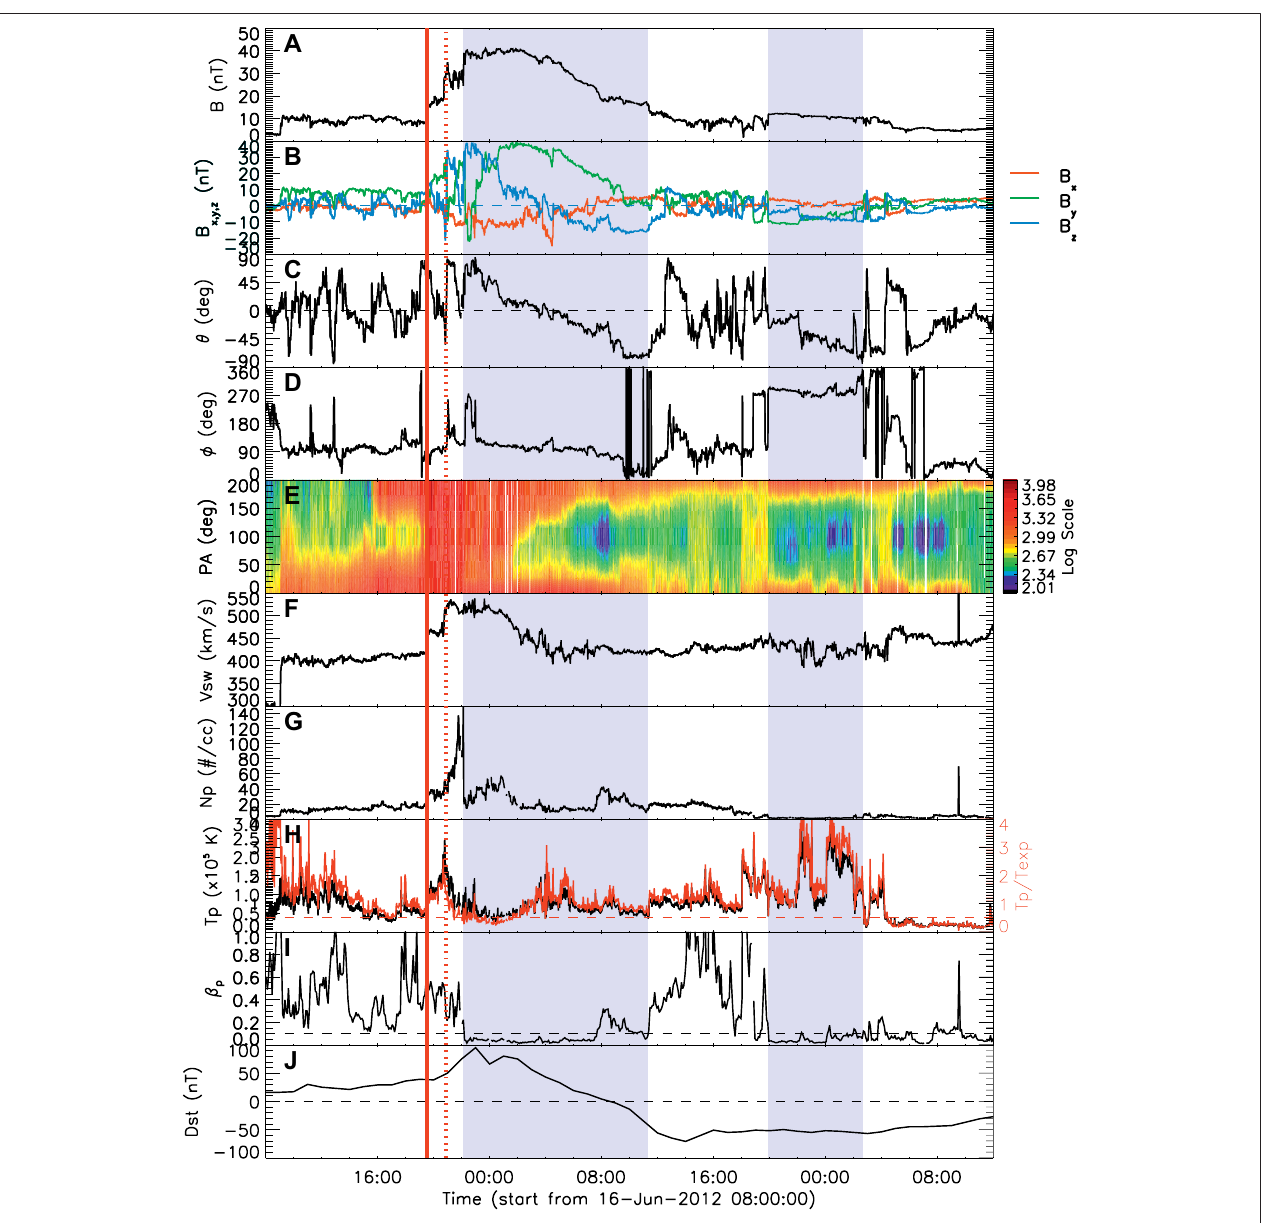
FIGURE 4 | Wind observations from 2012 June 16 to 2012 June 18. The panels are the same as in Figure 1 .